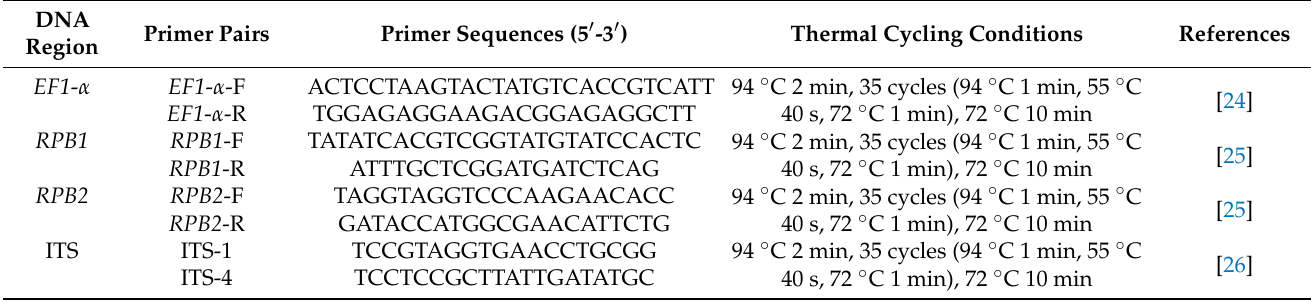
Table 1. Barcode primers and reaction conditions.